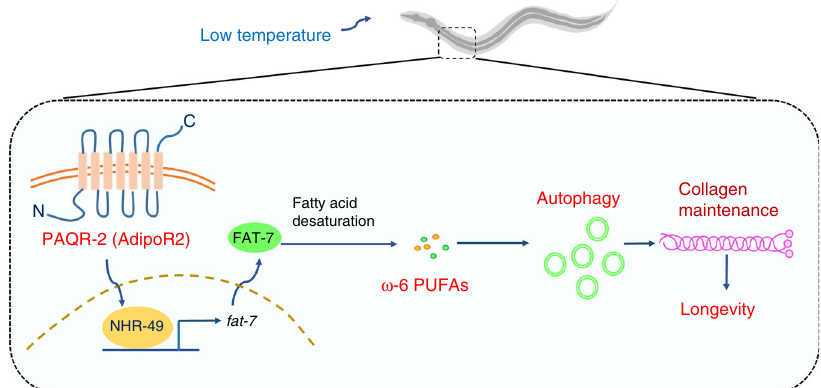
Fig. 6 Schematic model for the PAQR-2 signaling-mediated longevity at low temperature. At low temperature, the adiponectin receptor PAQR-2 upregulates the expression of fat-7 , which encodes a stearic CoA desaturase, by the nuclear receptor NHR-49 in worms. FAT-7 promotes the biosynthesis of two ω -6 PUFAs, γ -linolenic acid and arachidonic acid, which in turn induce autophagy. Increased autophagic activity in the epidermis delays an age- related decline in collagen contents to promote